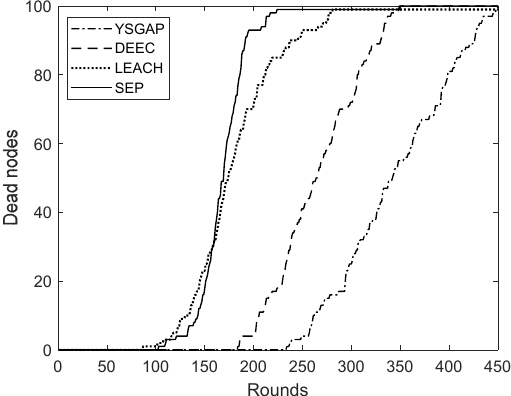
Figure 2. Network lifetime: dead nodes history.